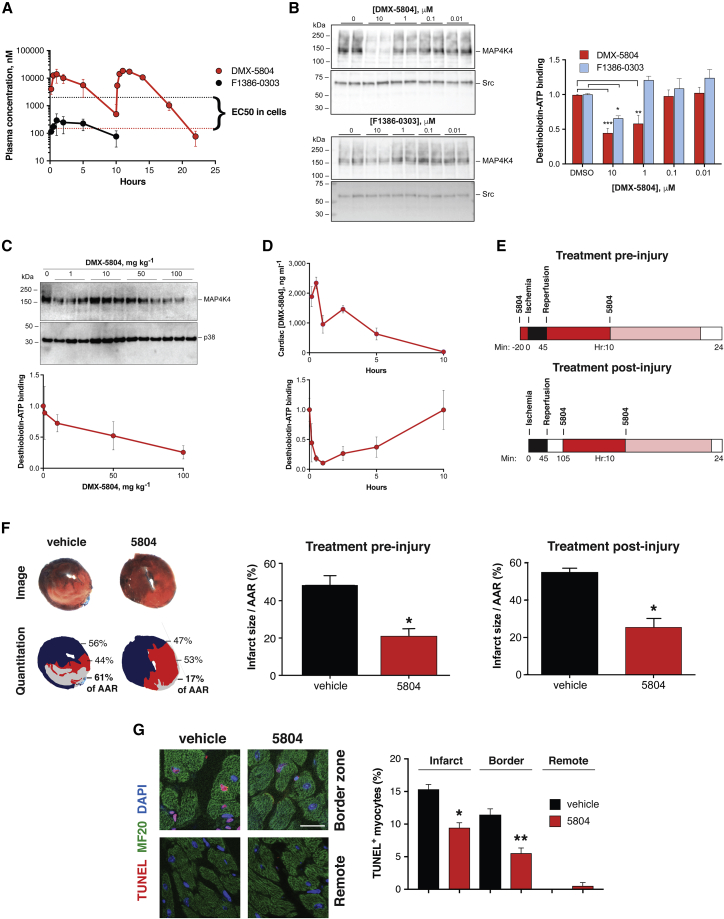
MAP4K4 Inhibition Reduces Infarct Size in Mice(A) Plasma concentrations of DMX-5804 versus F1386-0303 in mice, after oral doses of 50 mg kg−1. Whereas F1386-0303 levels were 10-fold less than the compound’s EC50 (black), sufficient in vivo coverage was achieved with DMX-5804 (red). Using a second dose at 10 h, levels exceeded the EC50 for nearly 1 day.(B–D) Target engagement, shown as a block to desthiobiotin-ATP binding by cardiac MAP4K4 ± the ATP-competitive inhibitors.(B) Target engagement ex vivo, in adult mouse cardiac lysates, demonstrates 10× greater affinity for DMX-5804.(C and D) Target engagement in vivo, shown for (C) dose response and (D) time course. Cardiac levels of DMX-5804 (above) conformed to the time course for plasma concentrations and reciprocal with the levels of ATP binding to cardiac MAP4K4 (below).(E) Schematic representation of the pre- and post-injury treatment protocols (not to scale). Mice were given the first dose of DMX-5804 20 min before the onset of ischemia (above) or 1 h after reperfusion was initiated (below). Black, ischemia; red and light red, intervals of coverage by the first and second dose, respectively. Dosing was chosen to exceed the compound’s EC50 for 20 h (Figure 2E).(F) Infarct size. (Left) Representative tissue sections 24 h after myocardial infarction ± DMX-5804 are shown. (Above) TTC/Evans blue staining to delineate infarct size (white) and area at risk (AAR) is shown. (Below) Image analysis and quantitation are shown. (Center) Pre-injury treatment with DMX-5804 reduces infarct size/AAR. N ≥ 5; ∗p = 0.0021. (Right) Post-injury treatment with DMX-5804 reduces infarct size/AAR. N ≥ 5; ∗p = 0.0015.(G) Cardiomyocyte apoptosis. (Left) Representative confocal microscopy of cardiomyocyte apoptosis 24 h after myocardial infarction ± DMX-5804 is shown. Myocytes are shown in short-axis orientation. Scale bar, 20 μm. (Right) Post-injury treatment with DMX-5804 reduces cardiomyocyte apoptosis. n = 4; ∗p = 0.0014; ∗∗p = 0.0028. Representative images (F and G) are taken from the post-injury treatment study.Results are shown as the mean ± SE.